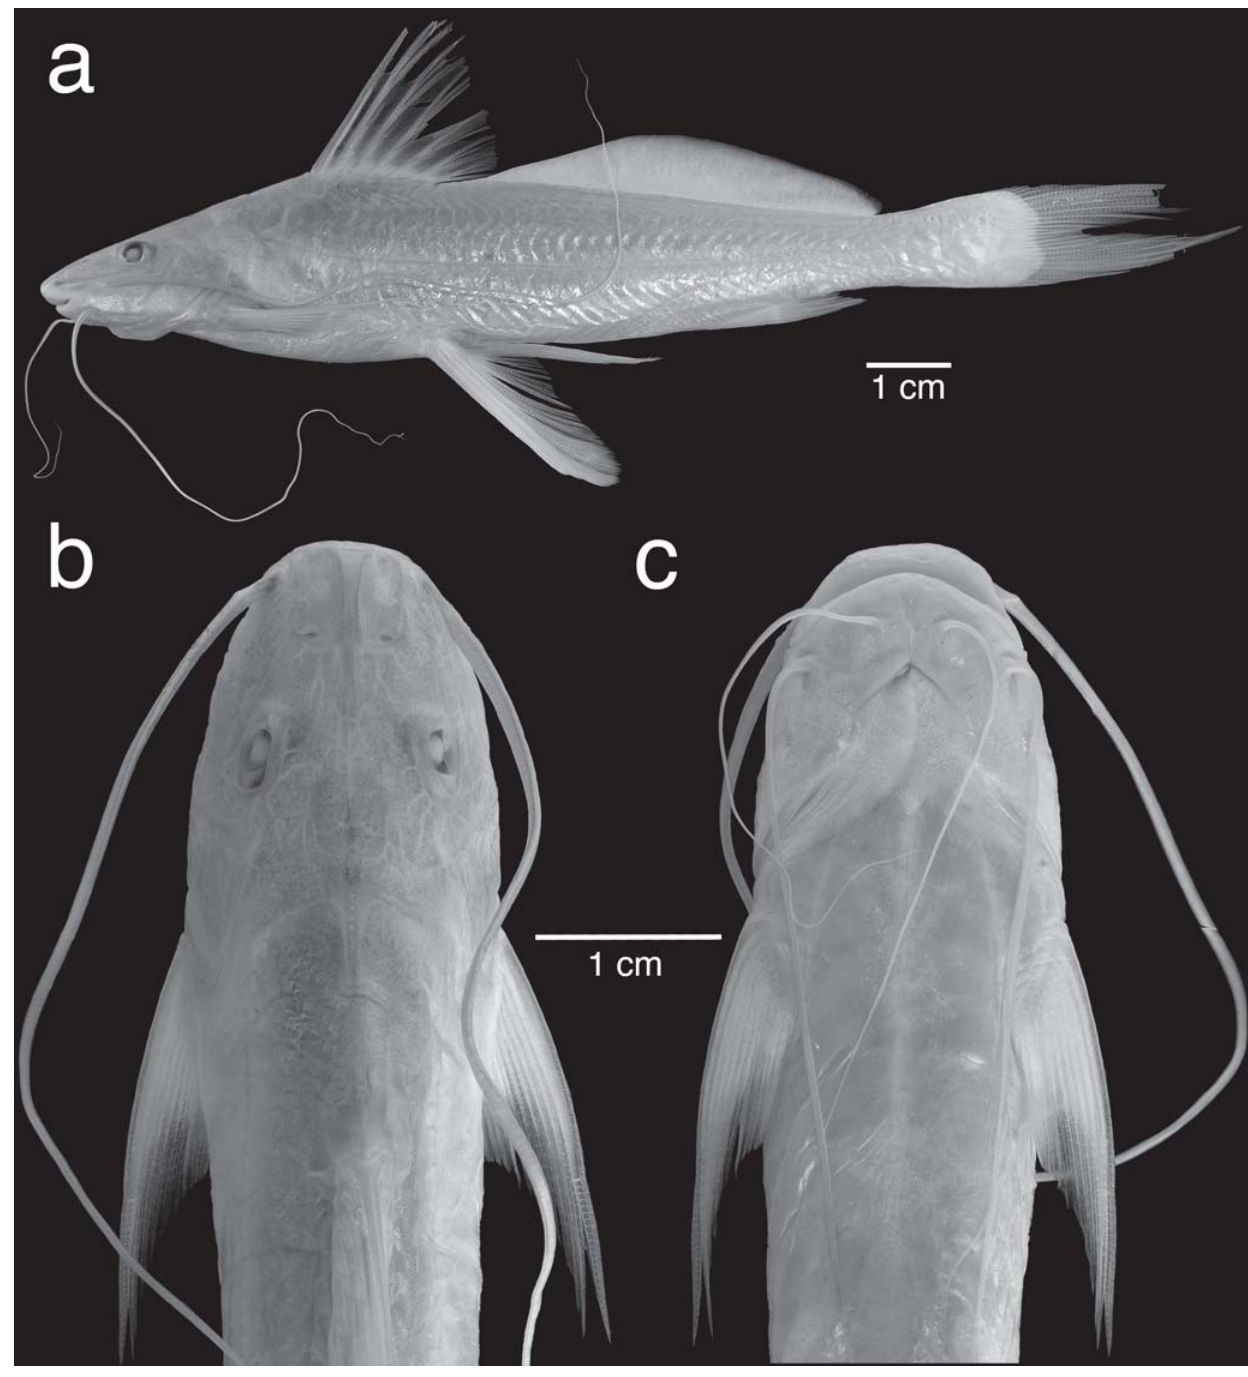
Fig. 4. Megalonema xanthum , CAS 63674, paratype, 118 mm SL, in a , lateral, b , dorsal and c , ventral by thin skin, skull roofing bones relatively smooth, not orna- mented with tubercles or ridges. Snout moderately long, con- tained 2-2.3 in head length, and with broadly rounded margin in dorsal and ventral views. Snout and upper jaw projecting; with mouth closed less than half of premaxillary dentition exposed. Anterior nostril behind snout margin in a shallow, circular depression, its aperture dorsally directed and encircled